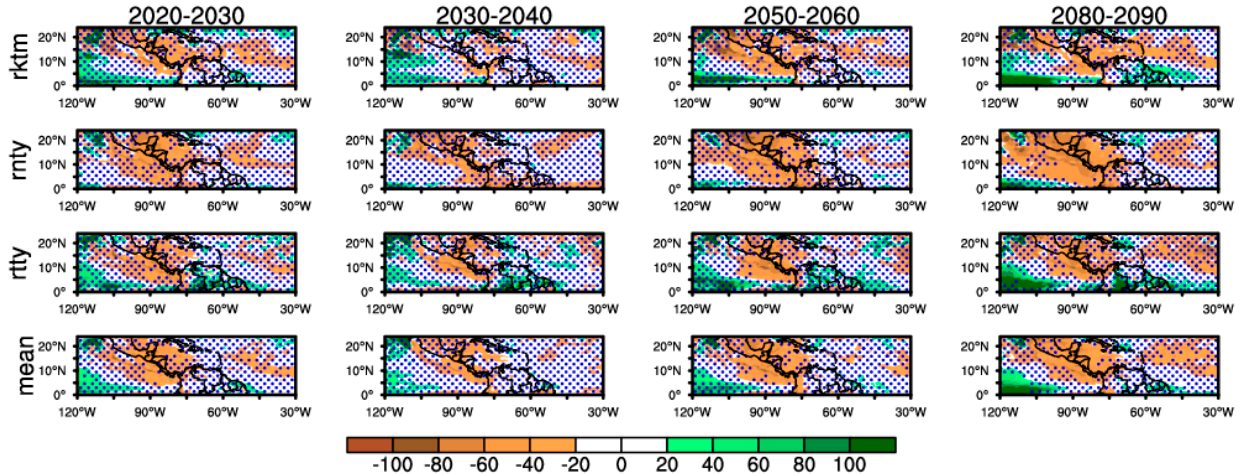
Figure 8. Mean annual percent change (%) in precipitation associated with Easterly Waves in the future ensemble runs with respect to the reference period (1990–2000). The dotted regions indicate a 95% significance level applying the Kolmogorov– Smirnov two-sample